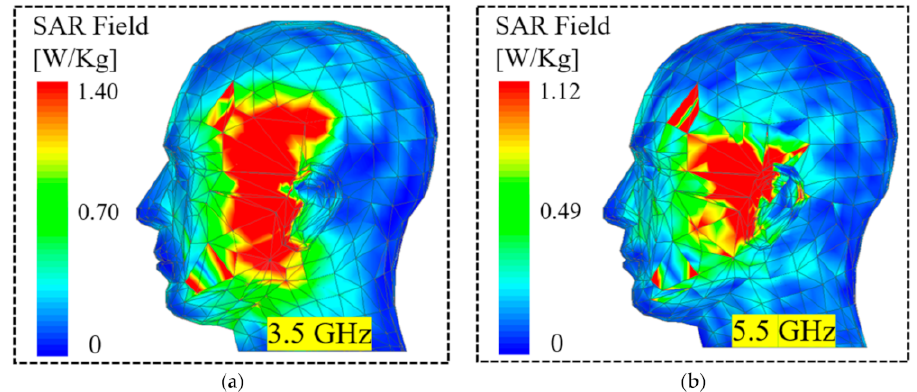
Figure 10. SAR Analysis of proposed dual band Antenna. ( a ) 3.5 GHz ( b ) 5.5 GHz. The comparison is given in Table 2. Comparison table is included in order to indicate